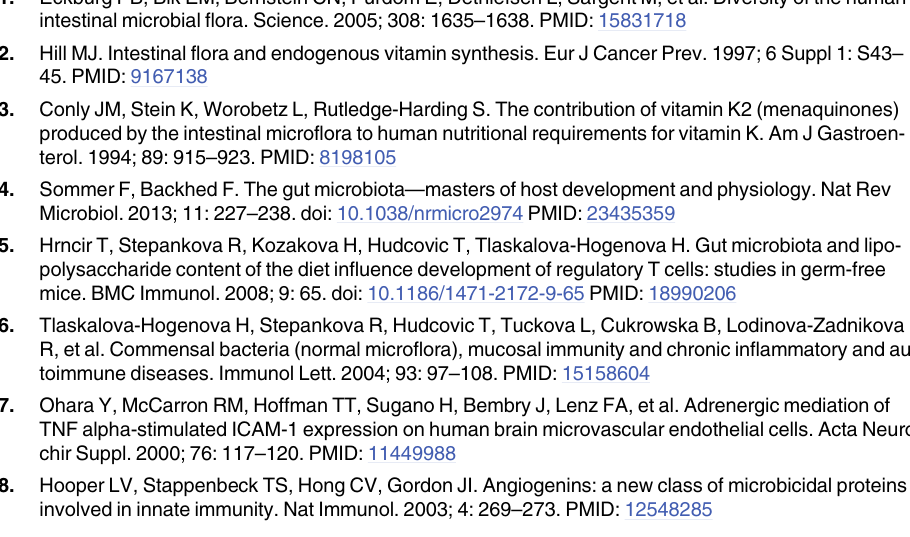
S1 Table. ANOVA main effects summary at the genus level. Summary of main effects ob- served following ANOVA at the genus level of taxonomy. These genera were differentially im- pacted by time, age, and